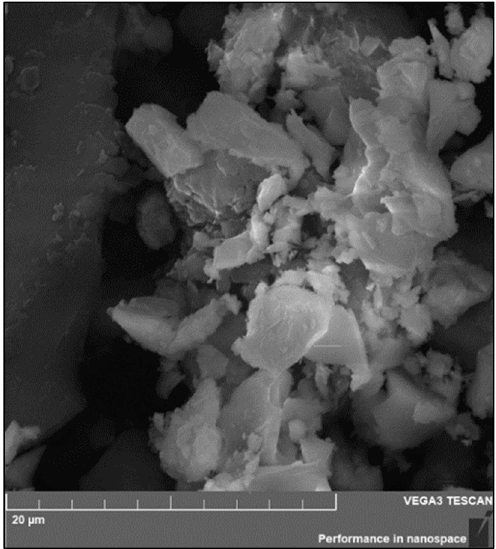
Figure 8. Humic acid aggregates.